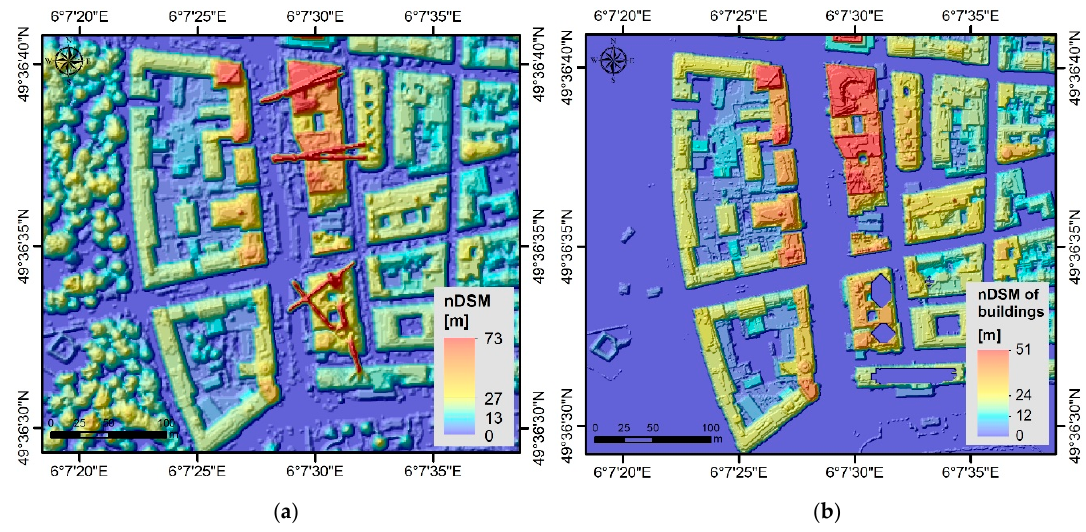
Figure 3. nDSM of building, vegetation and cranes on newly constructed buildings ( a ); nDSM of buildings only ( b ).